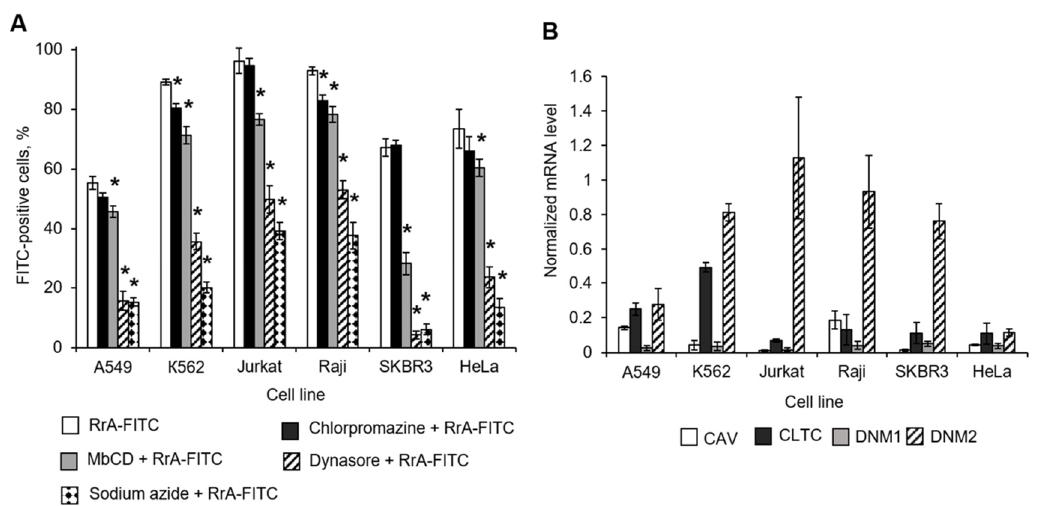
Figure 5. Inhibition of clathrin receptors a ff ects RrA interaction with cells. Di ff erent cell lines were exposed to the endocytosis receptor inhibitors for 30 min and incubated with FITC-conjugated RrA for 3 h, followed by flow cytometry. ( A ) Flow cytometry results. ( B ) Expression of CAV, CLTC DNM1 and DNM2 mRNA levels in di ff erent cell lines. The expression levels were normalized relative to the expression of the reference gene 18S. n = 4. * p ≤ 0.05 vs. cells treated with FITC-conjugated RrA. Table 3. The suppression e ffi ciency (U, %) of RrA-FITC interactions with cells by the receptor-mediated endocytosis inhibitors.